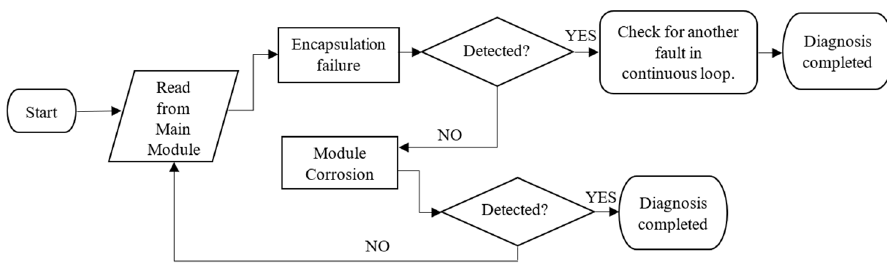
Figure 10. Flow chart for the python HMI fault detection algorithm.